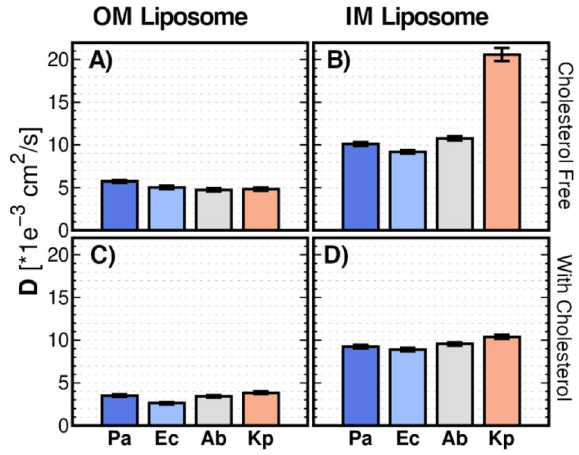
Figure 4. Diffusion Coefficient (D). Mean Diffusion coefficient from each individual molecule in: (A – B) OM and IM liposomes, respectively; (C – D) OM and IM liposomes containing cholesterol, respectively. Analysis performed on the last μs of the MD